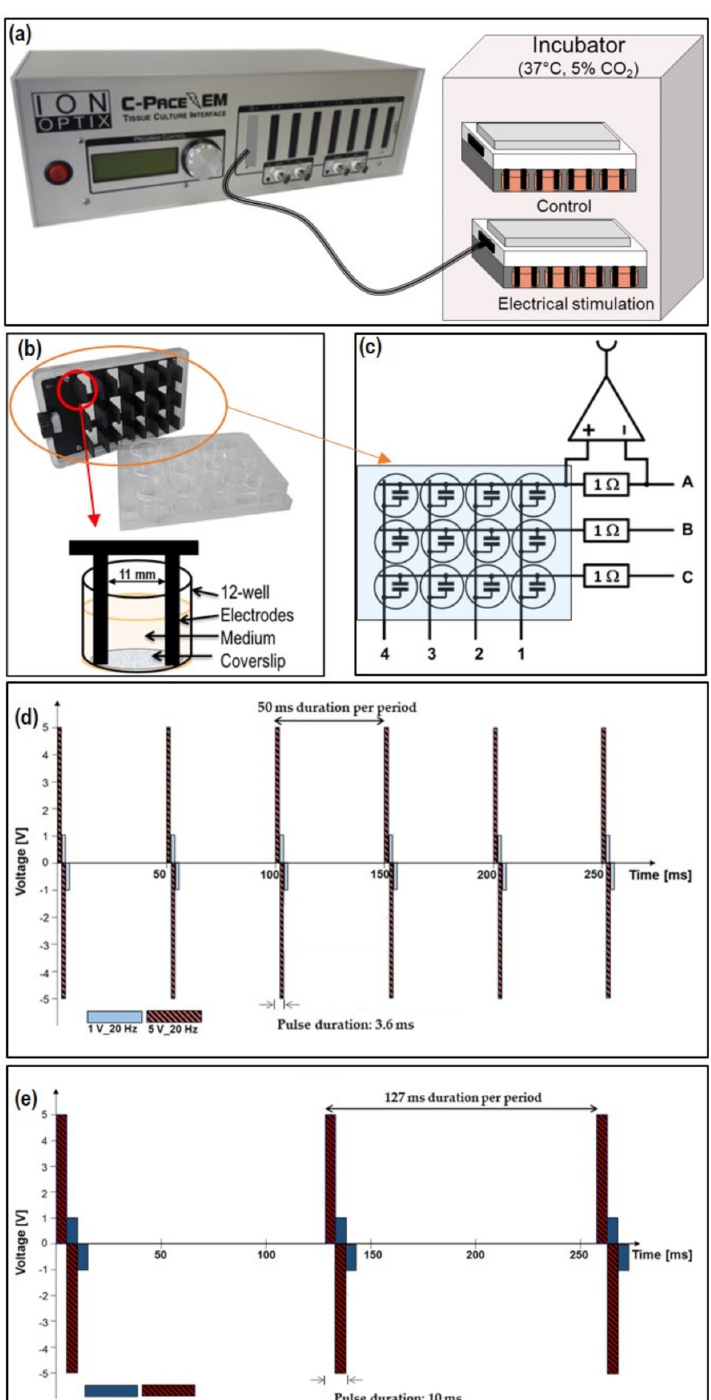
Figure 1. Scheme of the AC electrical stimulation system. ( a ) IonOptix stimulation chamber C-Pace EM 100—multi-channel stimulator, ( b ) graphite electrodes for a 12-well plate format reaching the bottom, and ( c ) simplified scheme of the 12 well C-Dish. For the current measurement, each column of the 12-well plate (background) is connected to the IonOptix controller via a shunt resistor. The corresponding voltage drop is amplified by an instrumentation amplifier which can be connected to any of the columns (not shown). In ( d ) illustration of rectangular electronic bipolar pulses of the AC stimulation with 20 Hz, and ( e ) 7.9 Hz. The pulse duration covers both positive and negative half